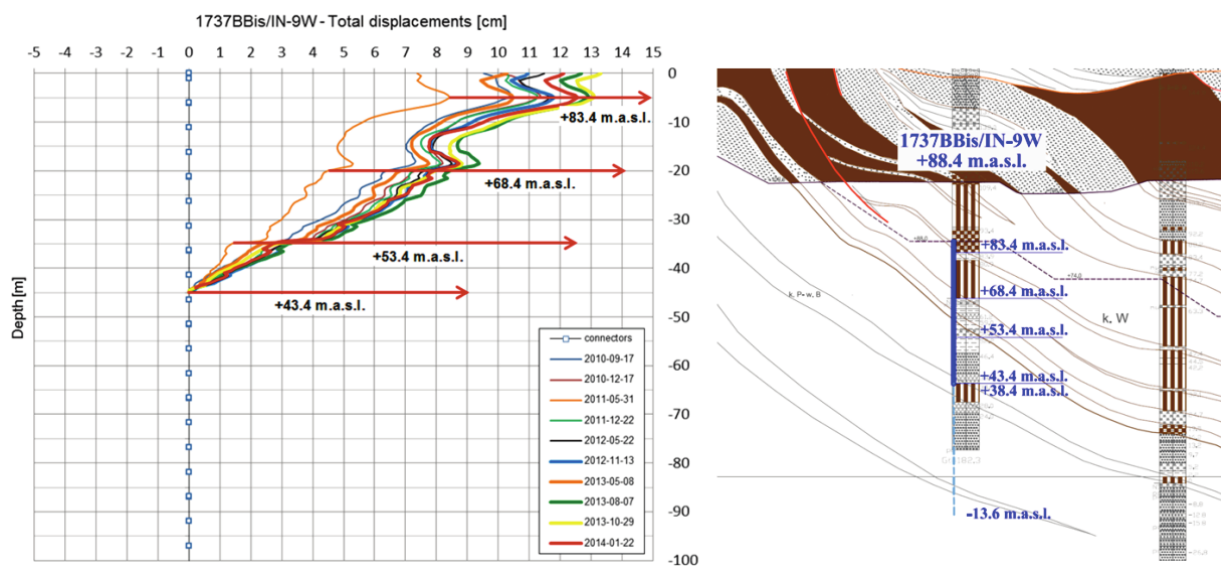
Fig. 11. The total horizontal displacements measured in inclinometer 1737BBis/IN-9W and the geological profile with potential slip surface levels (based on